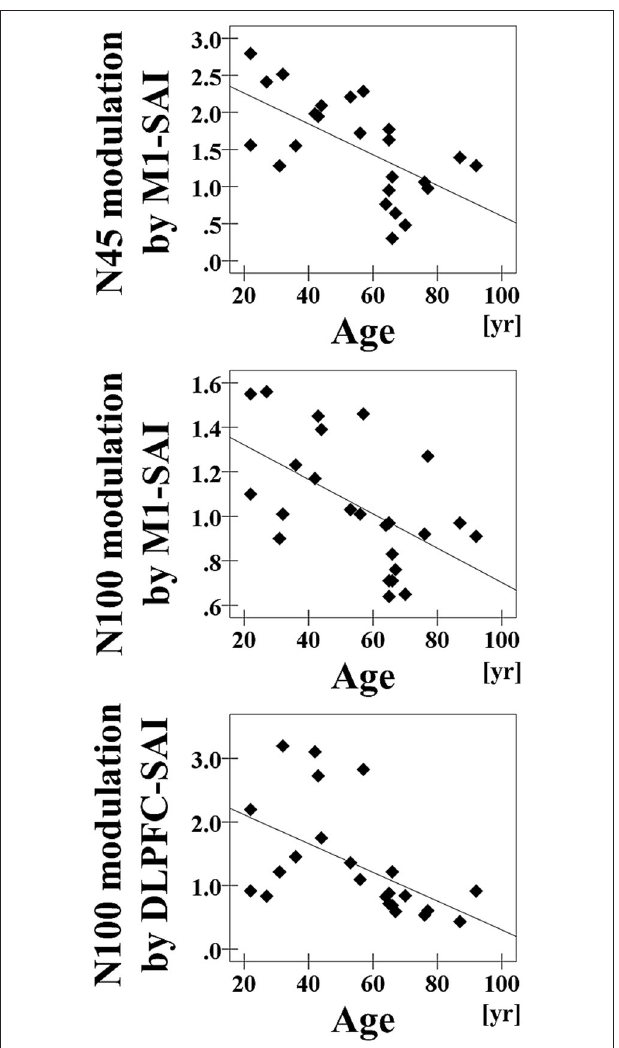
FIGURE 3 | Age-related correlations. The results of correlation analyses for all participants between age and the modulation of N45 TEP ( r = − 0.618, p = 0.001, N = 24) and between age and the modulation of N100 TEP ( r = − 0.548, p = 0.006, N = 24) at the left central ROI by M1–SAI, and between age and the modulation of N100 TEP ( r = − 0.529, p = 0.008, N = 24) at the left frontal ROI by the